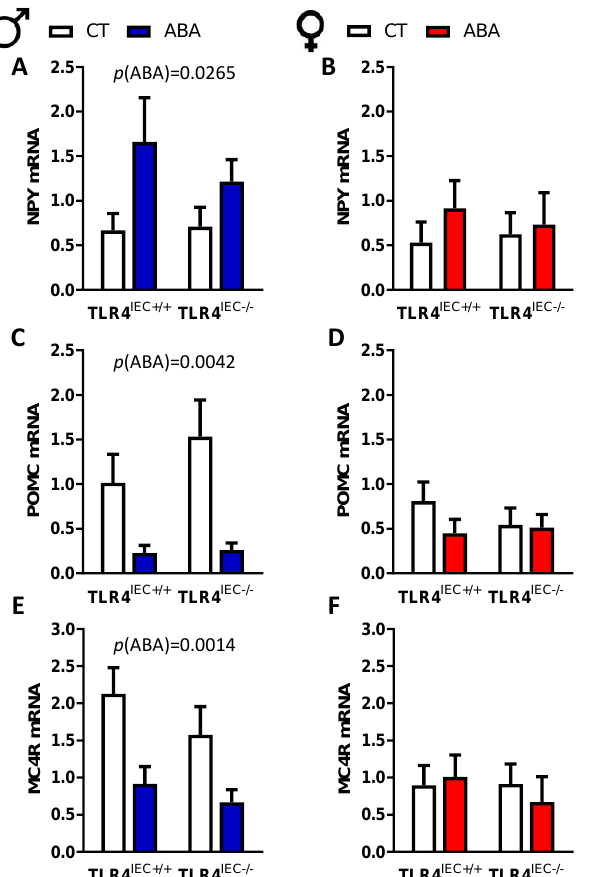
Figure 6. Hypothalamic neuropeptide Y (NPY), pro-opiomelanocortin (POMC) and melanocortin 4 receptor (MC4R) mRNA expression in male and female. NPY ( A ), POMC ( C ) and MC4R ( E ) hypothalamic mRNA expression between TLR4 IEC+/+ and TLR4 IEC − / − in CT (open bars) and ABA (blue bars) male mice. Female mice NPY ( B ), POMC ( D ) and MC4R ( F ) hypothalamic mRNA expression between TLR4 IEC+/+ and TLR4 IEC − / − in CT (open bars) and ABA (reds bars) female mice.